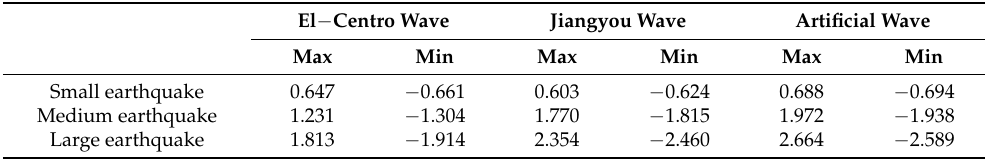
Table 3. The extremum acceleration of the top floor of the tower with no control condition under 8-degree earthquakes